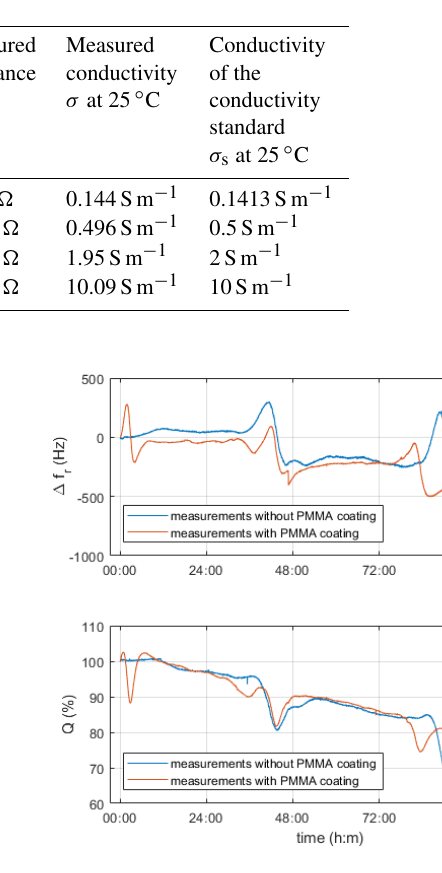
Figure 10. Comparison of coated and uncoated quartz electrodes during the measurement with ZPL and a reactor temperature of 60 ◦ C. Panel (a) shows changes in resonance frequency vs. time, and panel (b) shows the quality factor in relation to the starting val- ues vs.